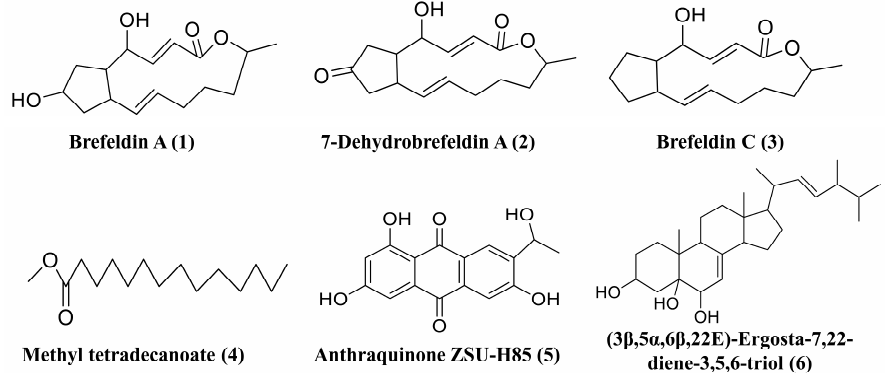
Figure 9. Six secondary metabolites isolated from D. alcacerensis CT-6.